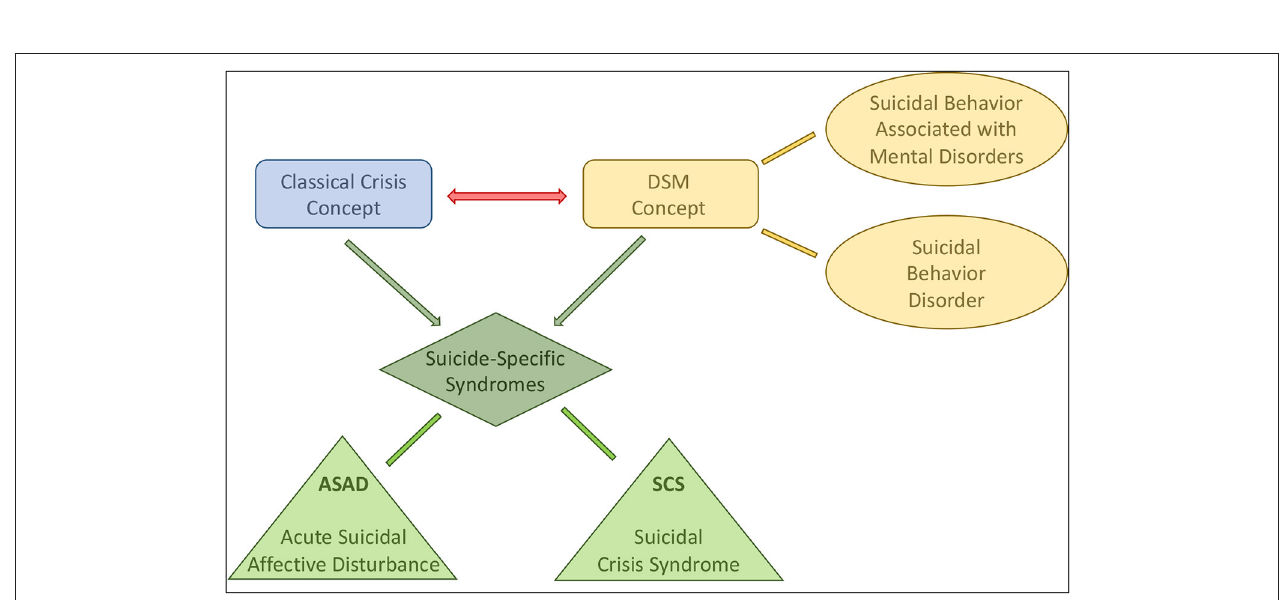
FIGURE 1 | Concept and development of the newly described suicide-specific syndromes [acute suicidal affective disturbance (ASAD) and suicidal crisis syndrome (SCS)]. The DSM-5 involves suicidal behavior disorder in its Appendix. Suicidal behavior may also be associated with different mental disorders, such as major depressive disorder, borderline personality disorder, etc. In contrast, the classical crisis theory, as a transdiagnostic concept, focuses on the emotional and psychological aspects of suicidal behavior, regardless of their potential association with mental disorders. Suicide-specific syndromes integrate these two major concepts with establishing well-defined diagnostic criteria, but also consider the acute psychological and psychopathological changes during the pre-suicidal period. Two different forms of suicide-specific syndromes were described recently, the ASAD and the SCS.